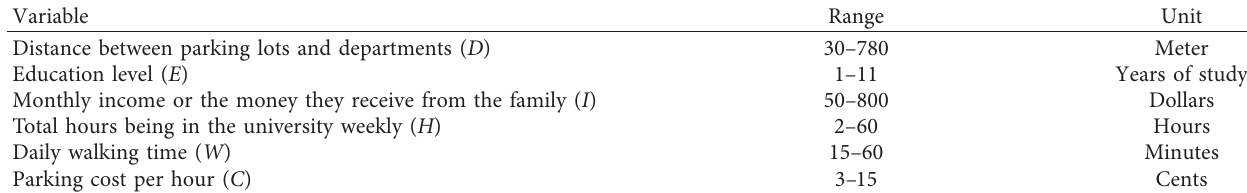
Table 7: Range of changes for input variables related to the FIS model.